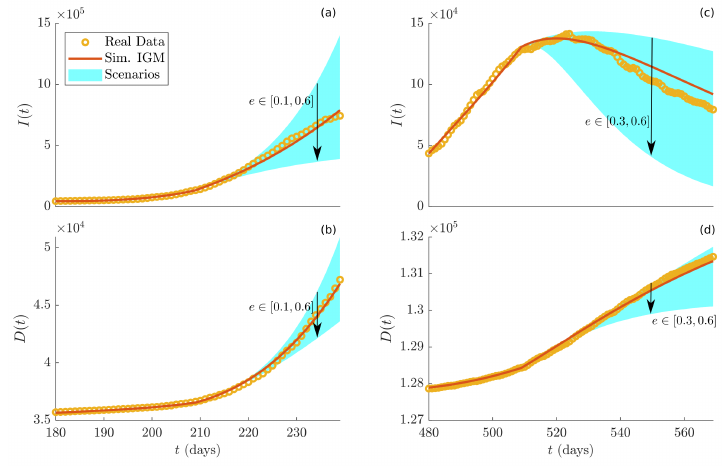
Figure 9. Two different scenarios obtained by varying the control parameter e at the beginning of the second wave (subplots ( a , b )), reporting infected and dead people, respectively) and at the beginning of the fourth (subplots ( c , d )), depicting infected and dead people, respectively). Yellow dots indicate real data, red curve is the simulation of the IGM using the estimated parameters, and the light blue area corresponds to the range of variations of the dynamics for different values of e .